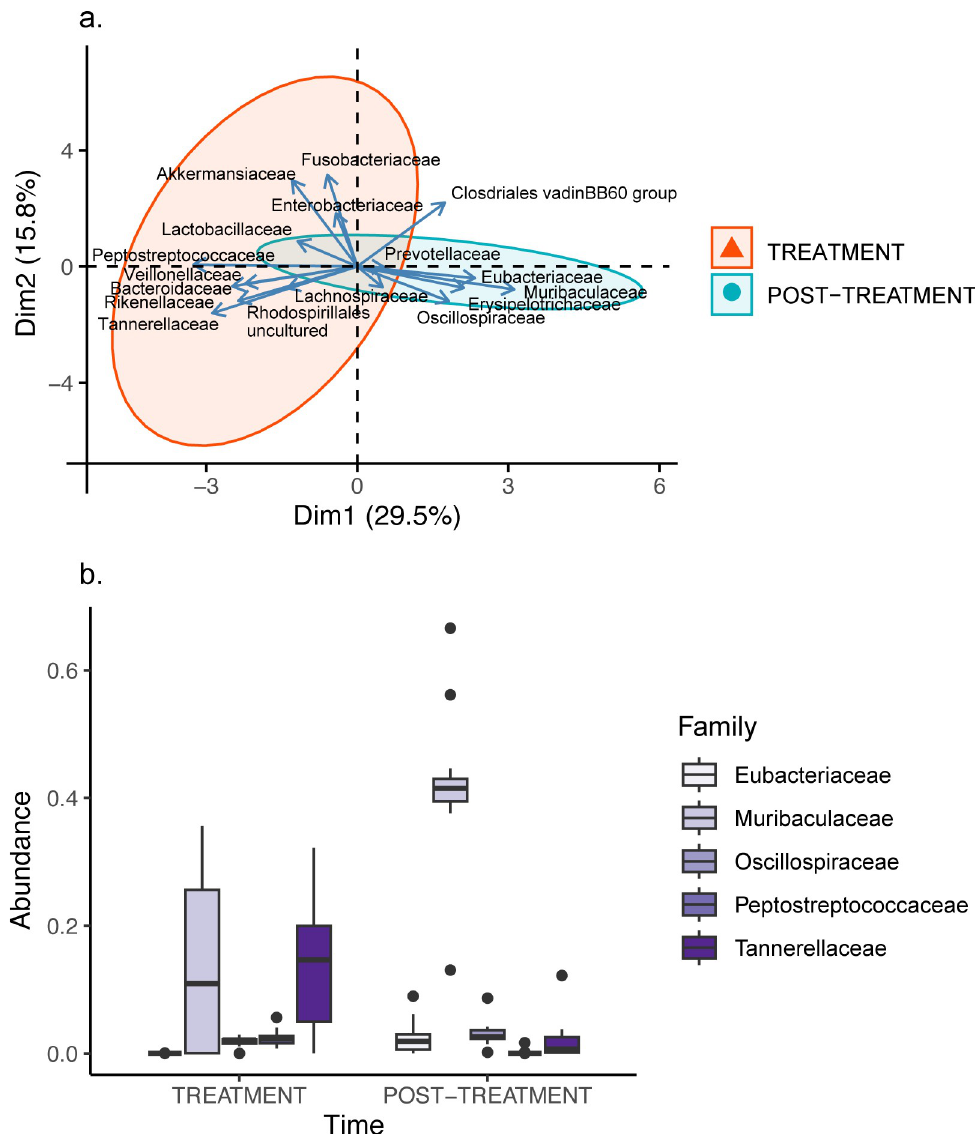
Fig 5. (a) Principal components analysis and (b) Box and whisker plot of 5 bacterial families in fawn-footed mosaic-tailed rat ( Melomys cervinipes ) faecal samples. Principal components analysis shows the first two principal components of 17 bacterial families for rats treated with antibiotics (red) and more than one year later (blue). Box and whisker plot of orders Eubacteriaceae (%), Muribaculaceae (%), Oscillospiraceae (%), Peptostreptococcaceae (%) and Tannerellaceae (%) for both